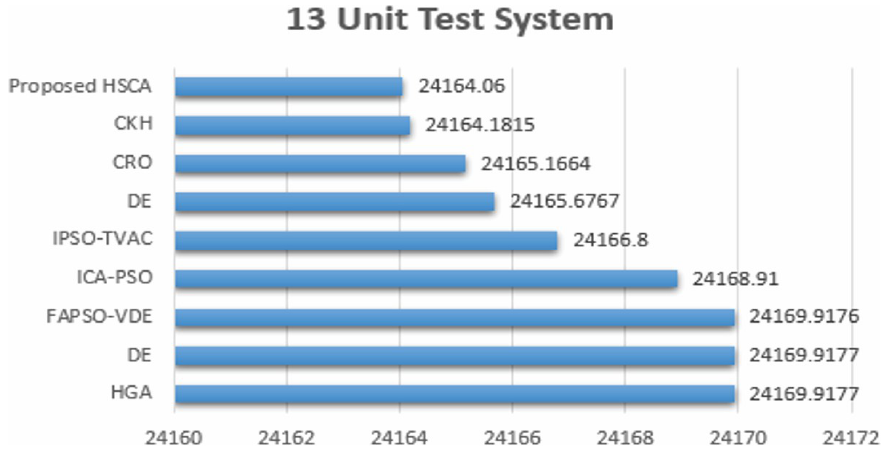
FIG. 5. COMPARISON OF FUEL COST FOR 13 UNIT TEST SYSTEM WITH THE DEMAND OF 2520 MW